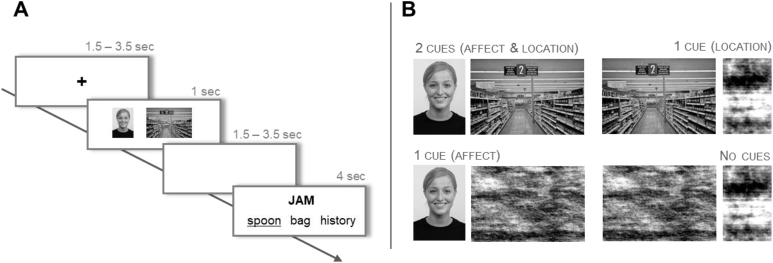
A. After an initial fixation cross (1500–3000 ​ms), participants were presented with cue images for 1000 ​ms, before moving to a blank screen (1500–3000 ​ms). Following that, a probe word was presented above a target and two unrelated distracters, triggering the onset of the decision-making period. The probe and choices remained visible for a fixed interval of 4000 ​ms. B. The four levels of the variable cue are shown.